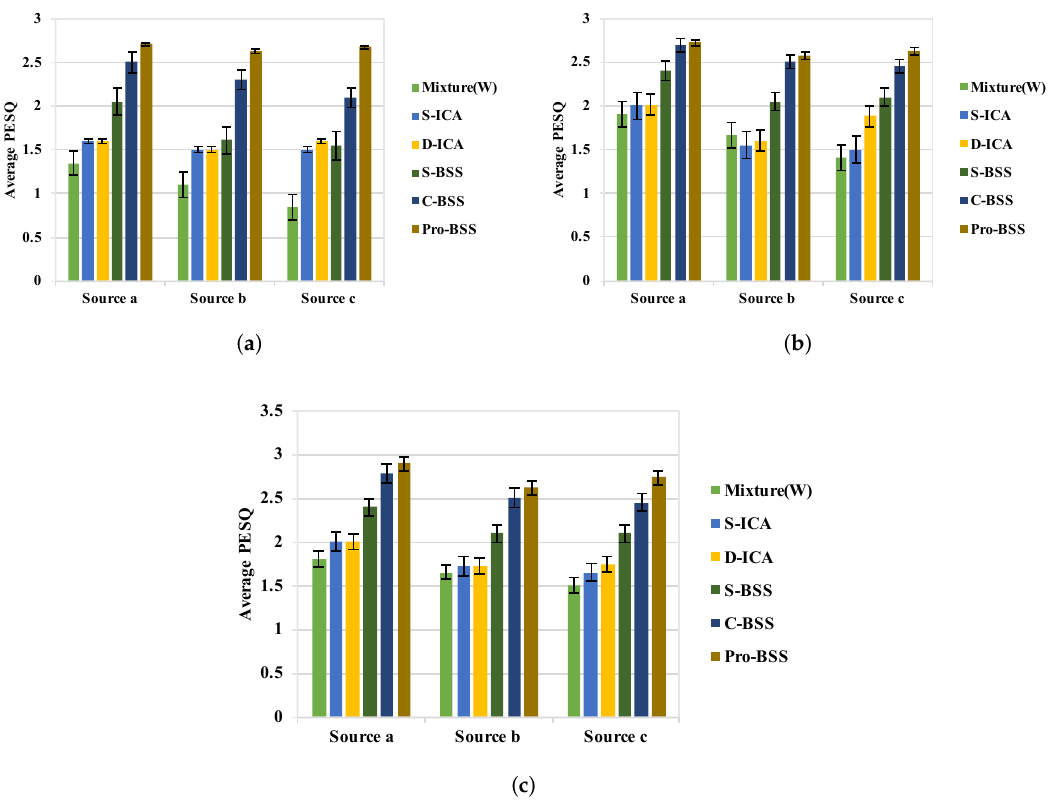
Figure 9. PESQ results ( a ) Anechoic Room; ( b ) Room1; ( c ) Room2. Error bars represent 95% confidence